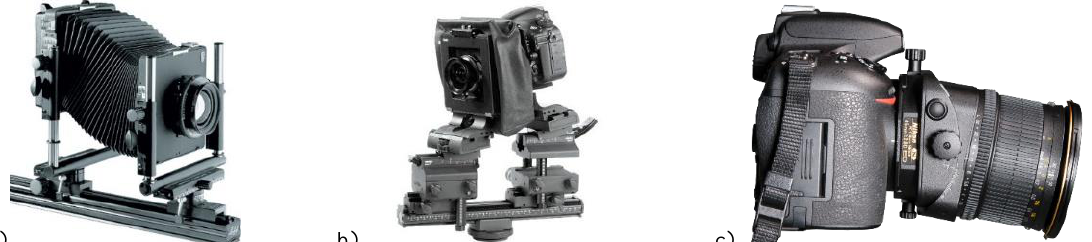
Figure 1. a) Linhof Kardan E view camera (http://www.fotografie-boerse.de/angebote_30_4/). b) Cambo Ultima 35: adapter for DSLR cameras (https://cambouk.wordpress.com/2013/09/26/cambo-special-offer-ultima-35-camera-bundles/). c) DSRL camera (Nikon D750) with a tilt-shift lens (PC-E Micro NIKKOR 45mm f/2.8D